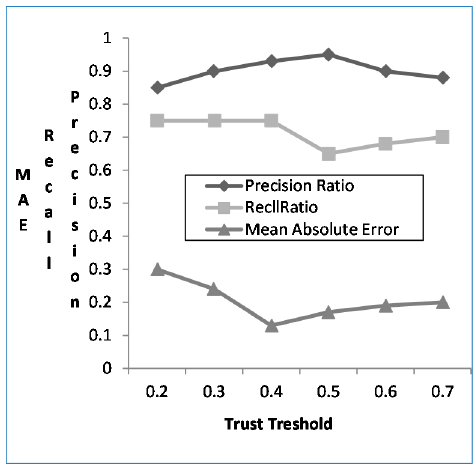
Figure 6. Recall and Precision for different trust threshold.